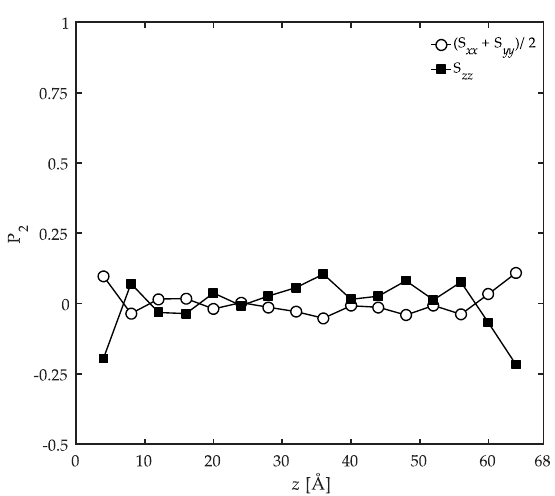
Figure 7. Values of the diagonal components of the Saupe matrix, S ab , as a function of z coordinate.